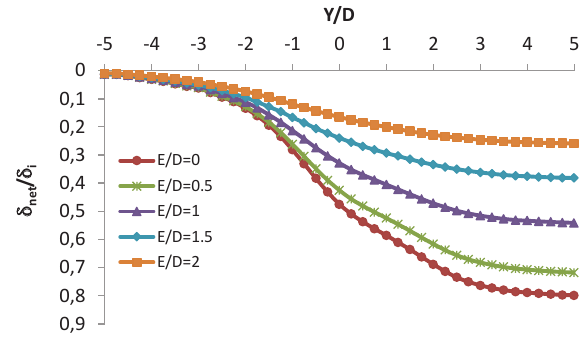
Figure 12: Variations of center pile head settlement at (3 x 3) piles group during tunnelling process for various E/D.